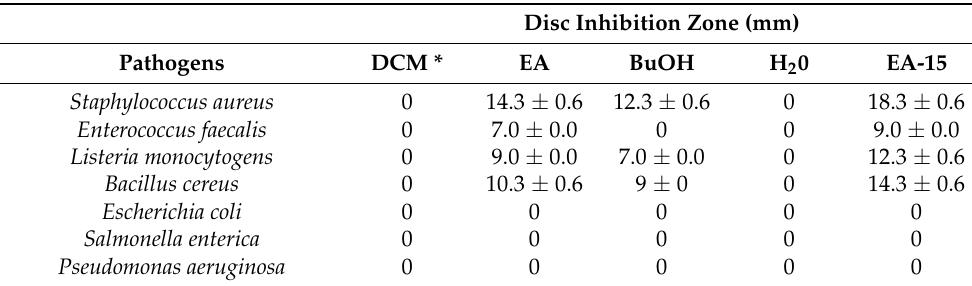
Table 1. The anti-bacterial activity of different fractions from V. emarginatum against human pathogens by the disc diffusion